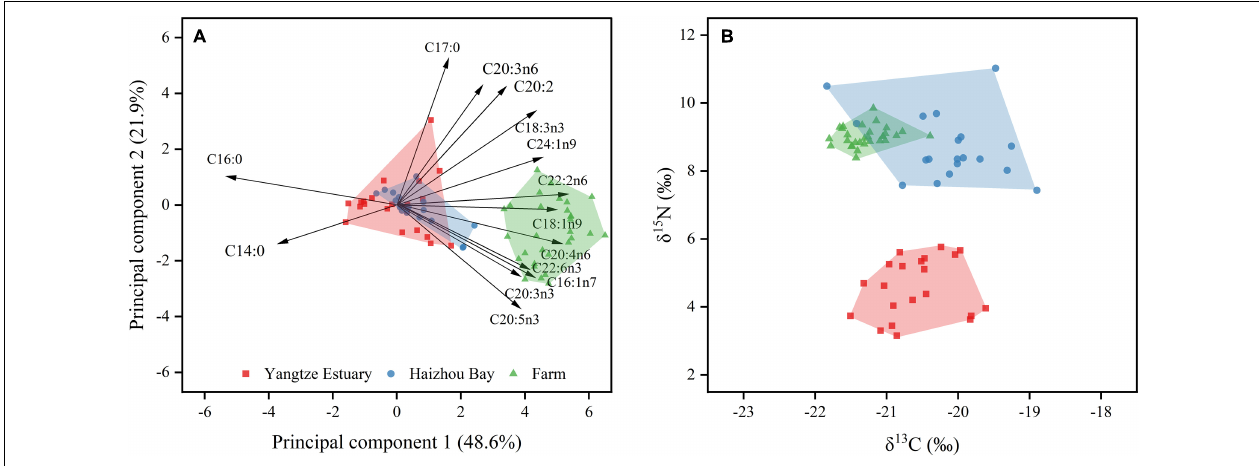
FIGURE 2 | Principal component analysis of fatty acid profiles (A) and stable isotopic ratios (B) of Rhopilema esculentum collected from three origins. Black arrows represent the direction of the component loadings for each FA with factor weights > 0.6 and < –0.6.